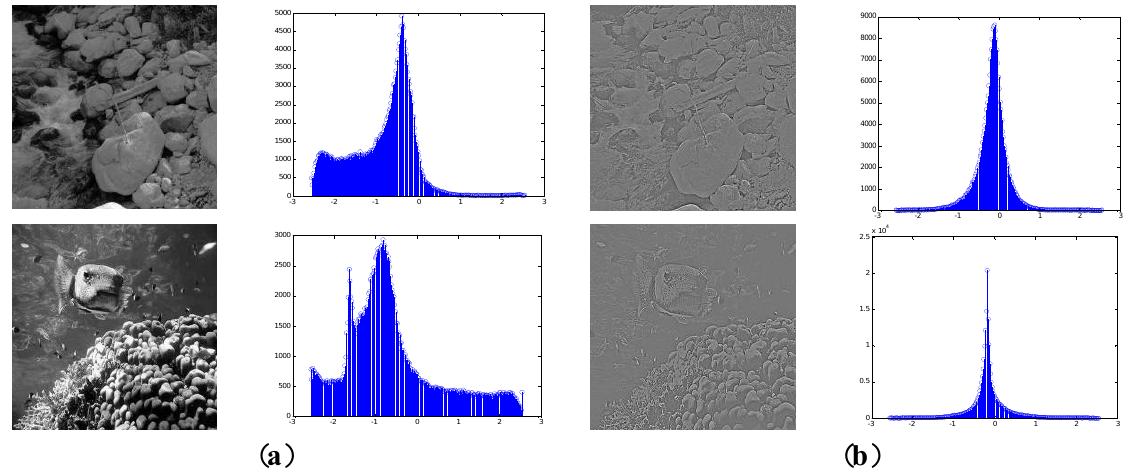
Figure 3. The distribution of the pixel values before and after pre-whitening transformation. ( a ) Original image and distribution. ( b ) Pre-whitened image and